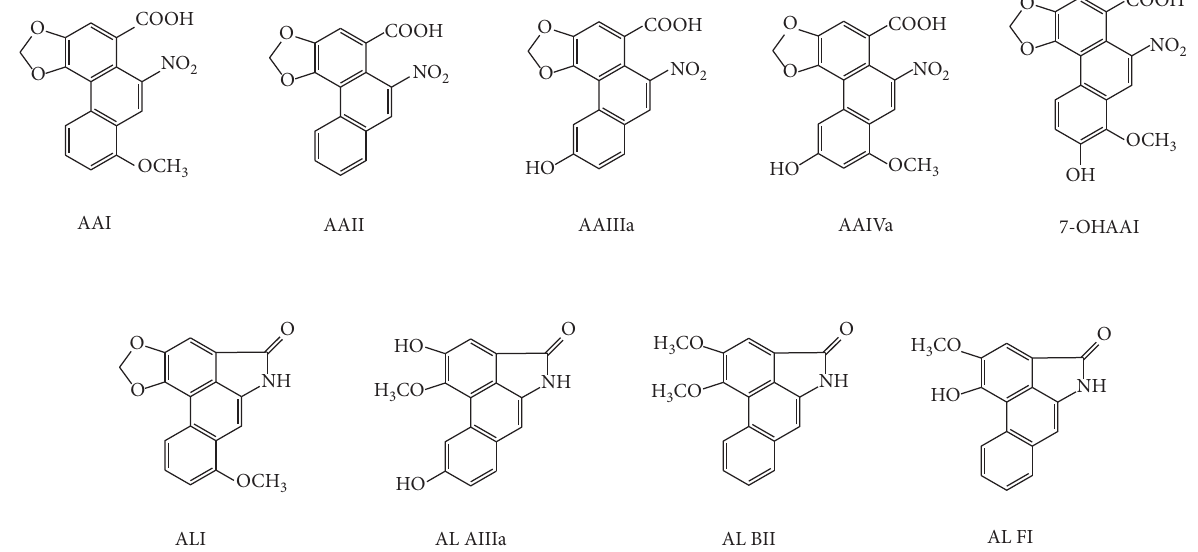
Figure 1: Chemical structures of aristolochic acid analogues. Table 1: MS parameters for 9 AA analogues reference